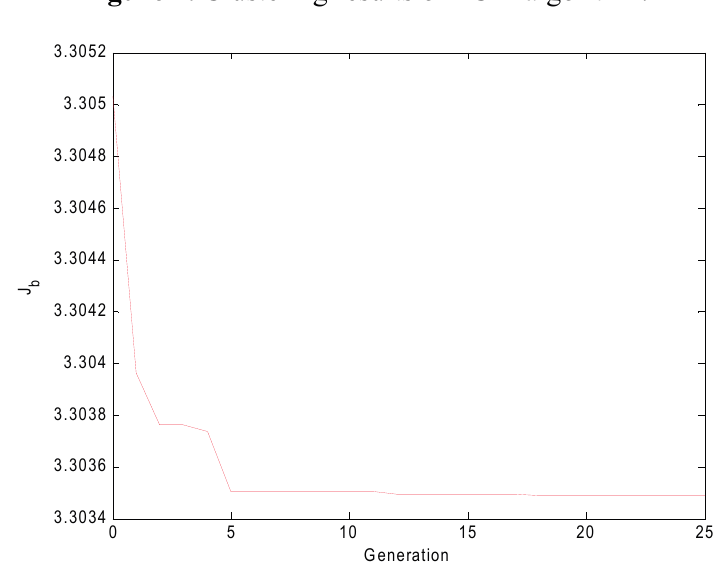
Figure 2. Clustering results of FCM algorithm.